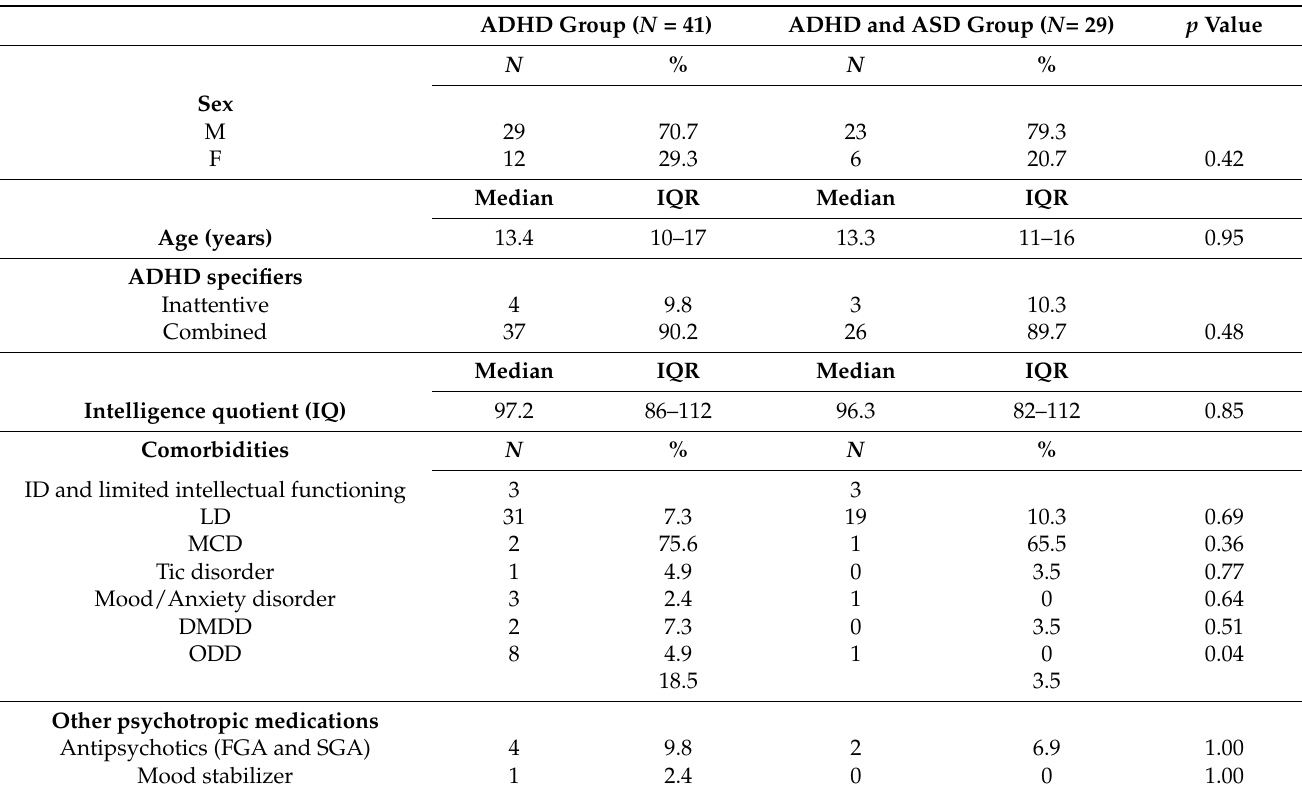
Table 2. Demographic and clinical characteristics of the sample, comorbidities, and other psychotropic medications in addition to MPH. ADHD Group ( N = 41) ADHD and ASD Group ( N = 29) p Value